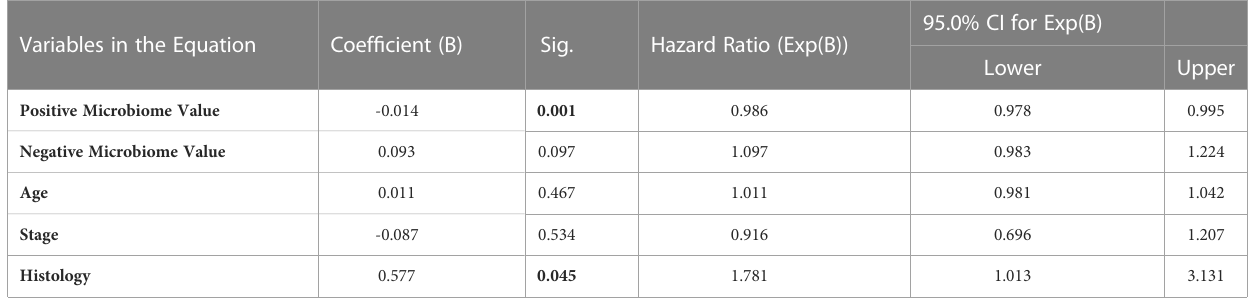
TABLE 2 Cox proportional hazards